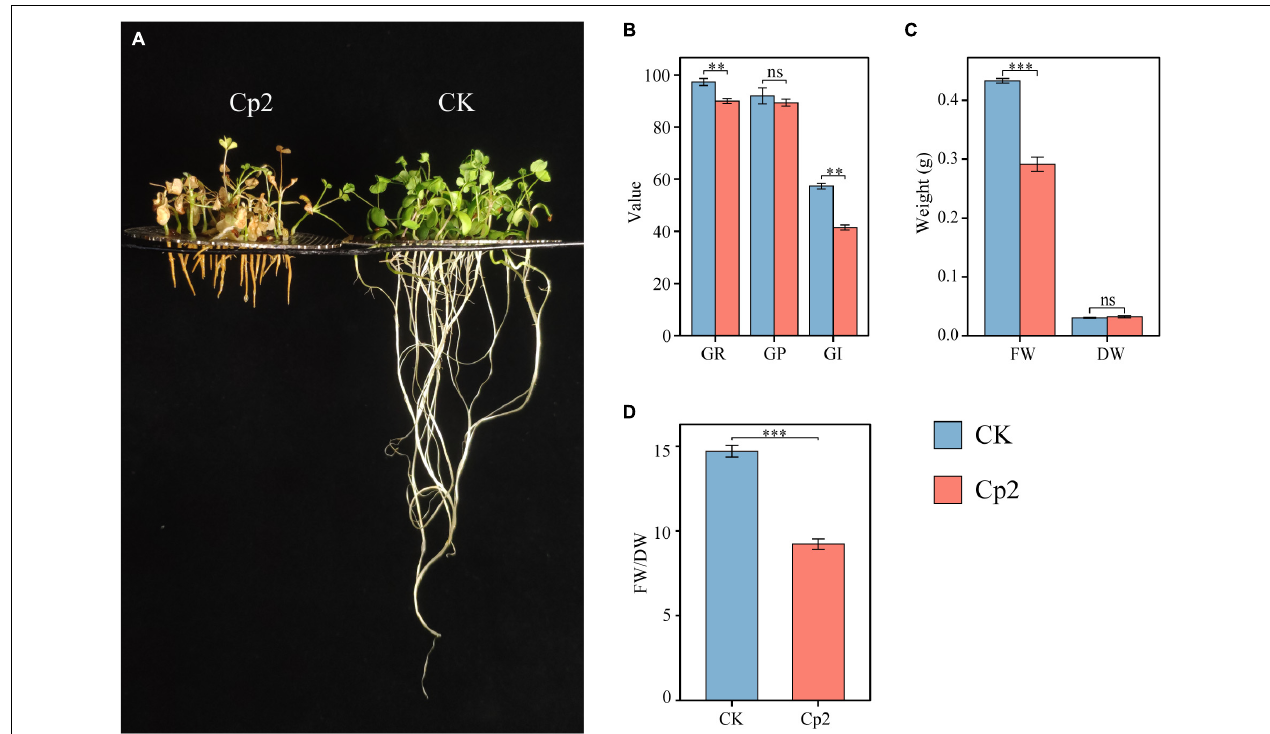
FIGURE 5 | Alfalfa phenotypes and growth indicators at 21 days after inoculation with E. persicina Cp2. (A) Phenotypic comparison between CK and Cp2 groups. (B) Comparison of germination between CK and Cp2 (Kruskal–Wallis test, Dunn’s test, n = 6). GR (%), germination rate; GP (%), germination potential; GI, germination index. (C) Fresh and dry weight compared to the CK (Independent samples t -test). FW, fresh weight; DW, dry weight. (D) FW/DW: fresh weight/dry weight matter (Mann–Whitney U test). ns: P ≥ 0.05, ∗∗ P < 0.01, ∗∗∗ P < 0.001; n = 6; mean ±